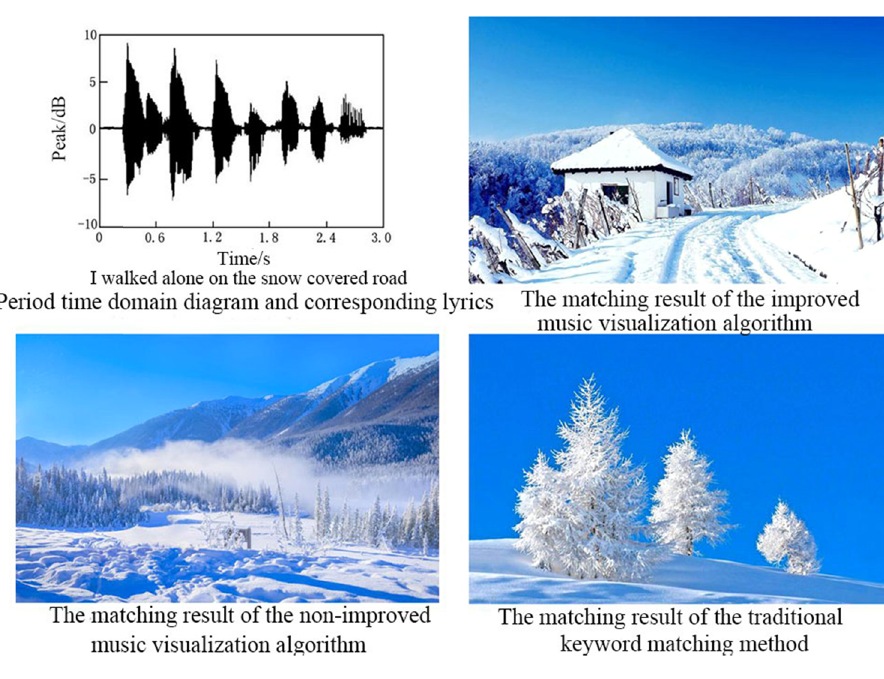
Figure 4: Partial matching results of three music visualization algorithms.